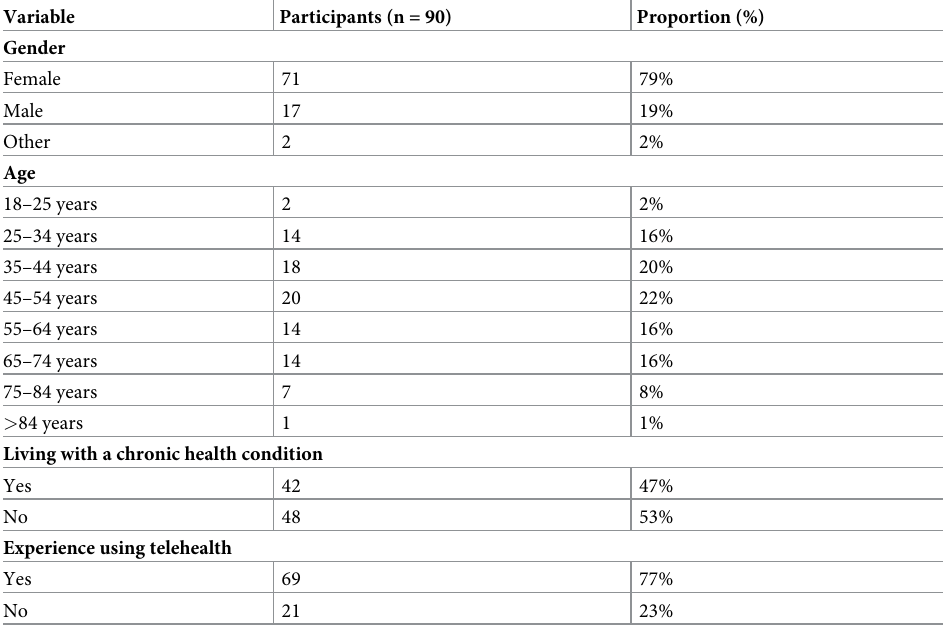
Table 1. Summary of participant demographic